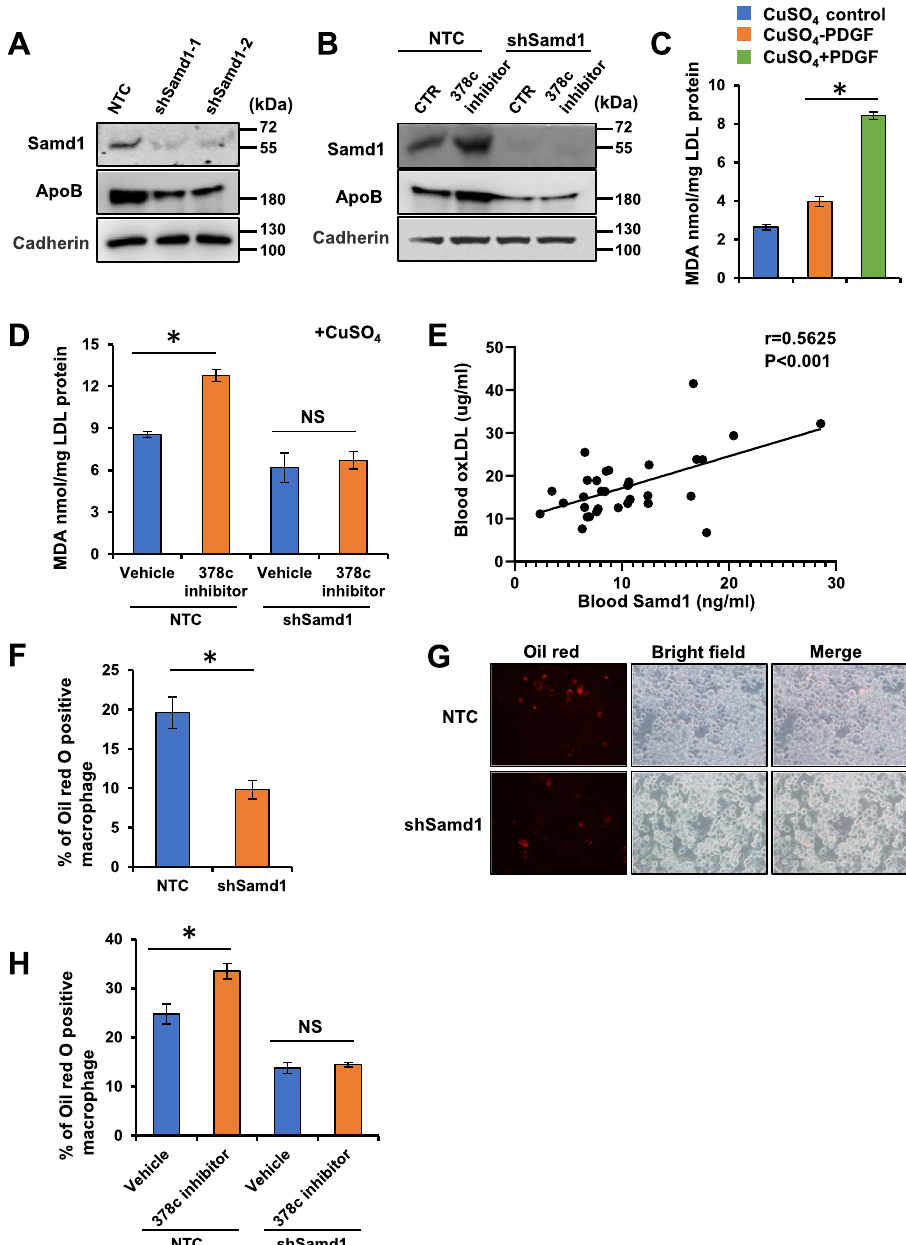
Figure 6. Samd1 facilitates LDL oxidation and foam cell formation. ( A ) VSMCs stimulated with PDGF-BB were further transfected with Samd1 shRNA or NTC and cultured with LDL, membrane Samd1 and ApoB were analyzed by western blot. Cadherin serves as a loading control. ( B ) VSMCs treated with PDGF-BB and miR- 378c inhibitor were further transfected with Samd1 shRNA or NTC and cultured with LDL, membrane Samd1 and ApoB were analyzed by western blot. Cadherin serves as a loading control. ( C ) VSMCs were stimulated with PDGF-BB and cultured with LDL. TBARS assay showing oxLDL formation. Data were presented as mean ± SD, n = 4. *P < 0.05 as compared with non-PDGF treated group. ( D ) VSMCs treated with PDGF-BB and miR-378c inhibitor were further transfected with Samd1 shRNA or NTC and cultured with LDL, followed by TBARS assay analysis of oxLDL formation. Data were presented as mean ± SD, n = 4. *P < 0.05 as compared between the indicated group. ( E ) Correlation between blood oxLDL level and blood Samd1 protein level. n = 30. Statistical significance was determined by the chi-square test. ( F , G ) VSMCs stimulated with PDGF-BB were further transfected with Samd1 shRNA or NTC and cultured with LDL, supernatants were collected and added to mouse bone-marrow-derived macrophages (BMDM) to induce foam cells formation. Oil red positive cells were counted. Data were presented as mean ± SD, n = 4. *P < 0.05 as compared PDGF-treated NTC group. ( H ) Supernatants from panel ( E ) were collected and added to BMDM to induce foam cells formation. Oil red positive cells were counted. Data were presented as mean ± SD, n = 4. *P < 0.05 as compared between the indicated